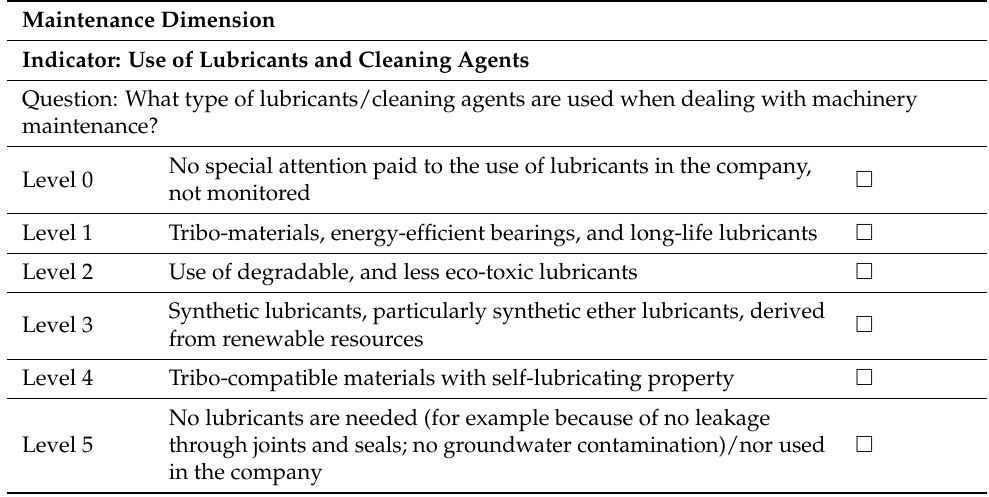
Table A2. An example of a question for evaluating the maintenance